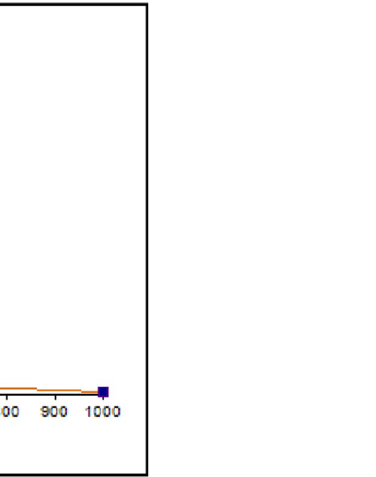
Fig 9. Message transmission time vs bandwidth over the wired